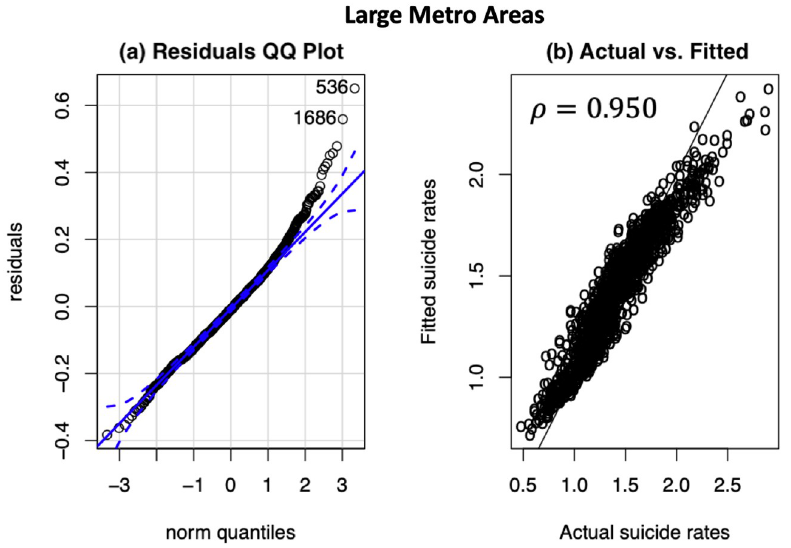
Fig 3. Large metropolitan counties: Model diagnostics of final random forest model. (A) Residuals QQ plot (the blue dashed lines represent 95% confidence intervals); (B) Predicted versus actual suicide counts, normalized per 100,000 of population.